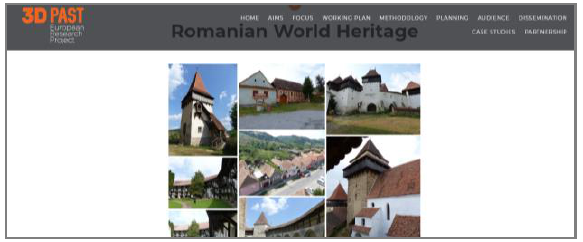
Figure 1. Project details from https://esg.pt/3dpast/.